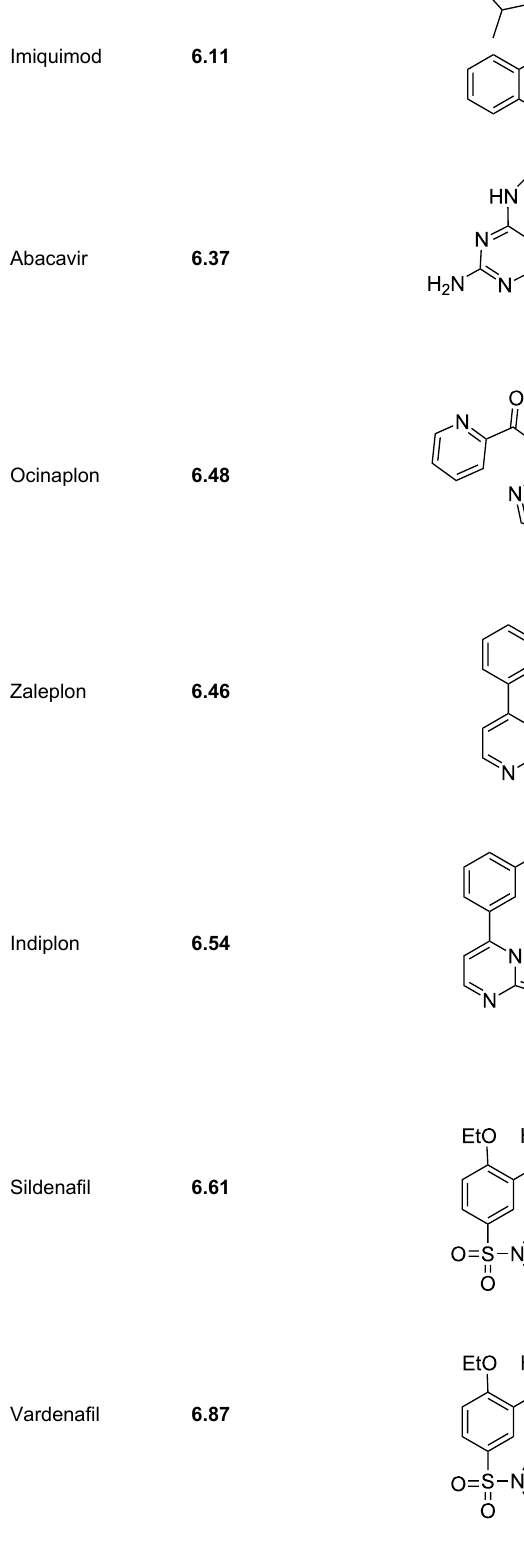
Table 1: Chemical structures of the heterocyclic compounds discussed in this review. (continued)